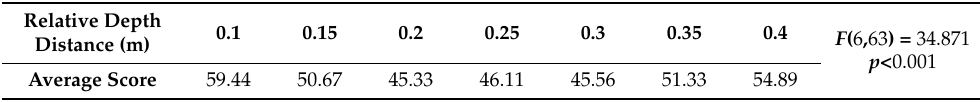
Table 20. The average subjective cognitive load of the task completed by the depth distance of different relative positions of the information display